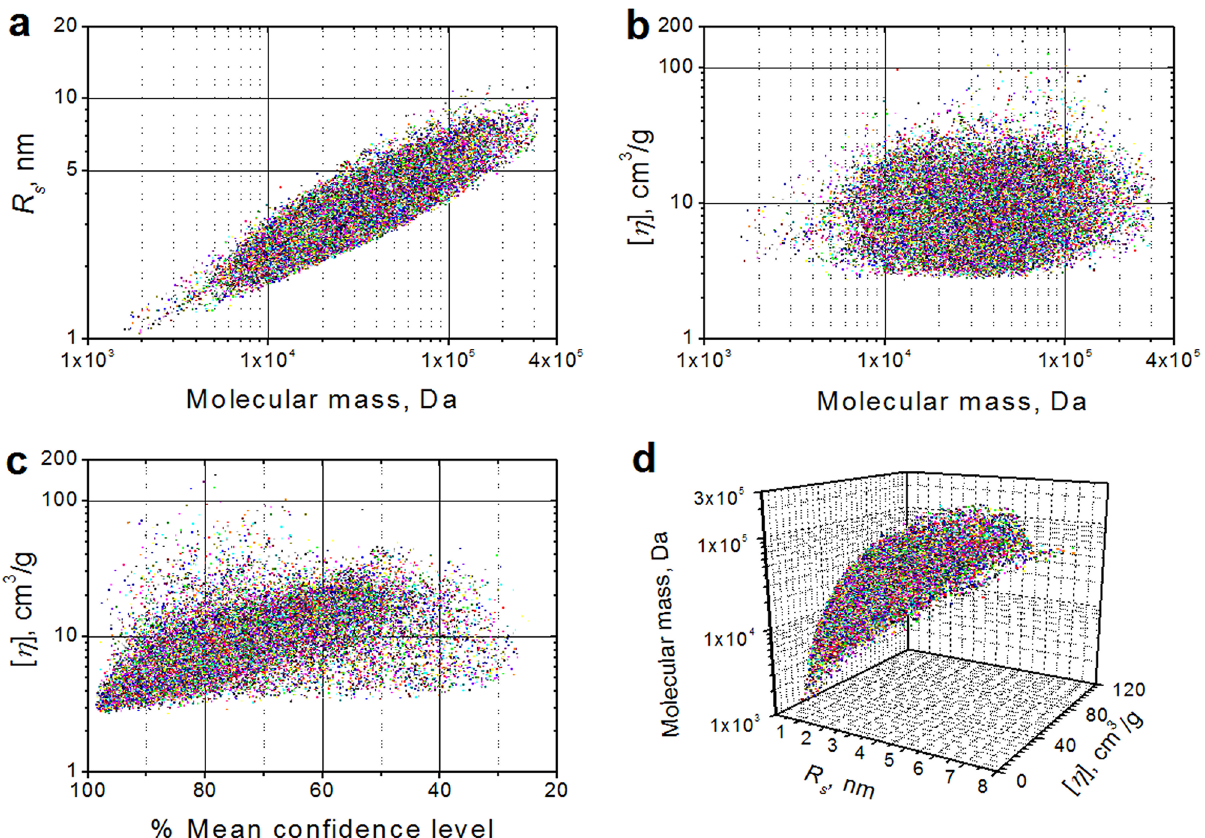
Figure 2. Plots of selected calculated parameters for 41,200 AF-v1 predicted structures with no corresponding entries in the solved structures PDB database. ( a ) R s vs. M , log–log scale. ( b ) [ η ] vs. M , log–log scale. ( c ) [ η ] vs. % decreasing mean confidence level, log-lin scale. ( d ) A 3D plot where M (log scale) is on the vertical Z -axis, and R s and [ η ] are on the horizontal X - and Y -axes, respectively (both linear